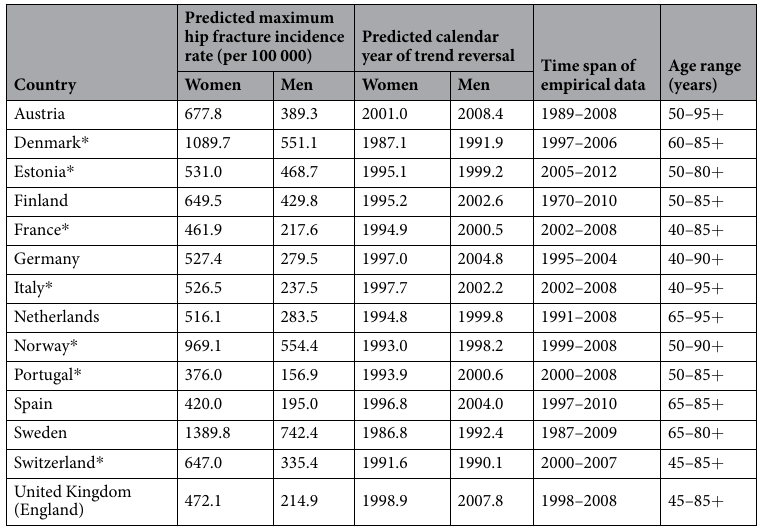
Table 3. Predicted values for maximum hip fracture incidence rate and calendar year of trend reversal using a mixed effects model. * Countries where model-predicted estimates of reversal year and peak rates were extrapolated (outside the time span covered by empirical